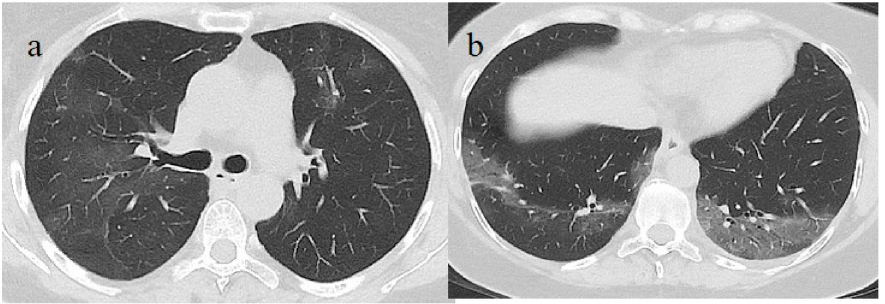
Figure 6. Chest CT was performed on 21 July. ( a ) The resolution of some GGO in the superior lobe. However, GGO continued to be present in the inferior lobe, as shown in ( b